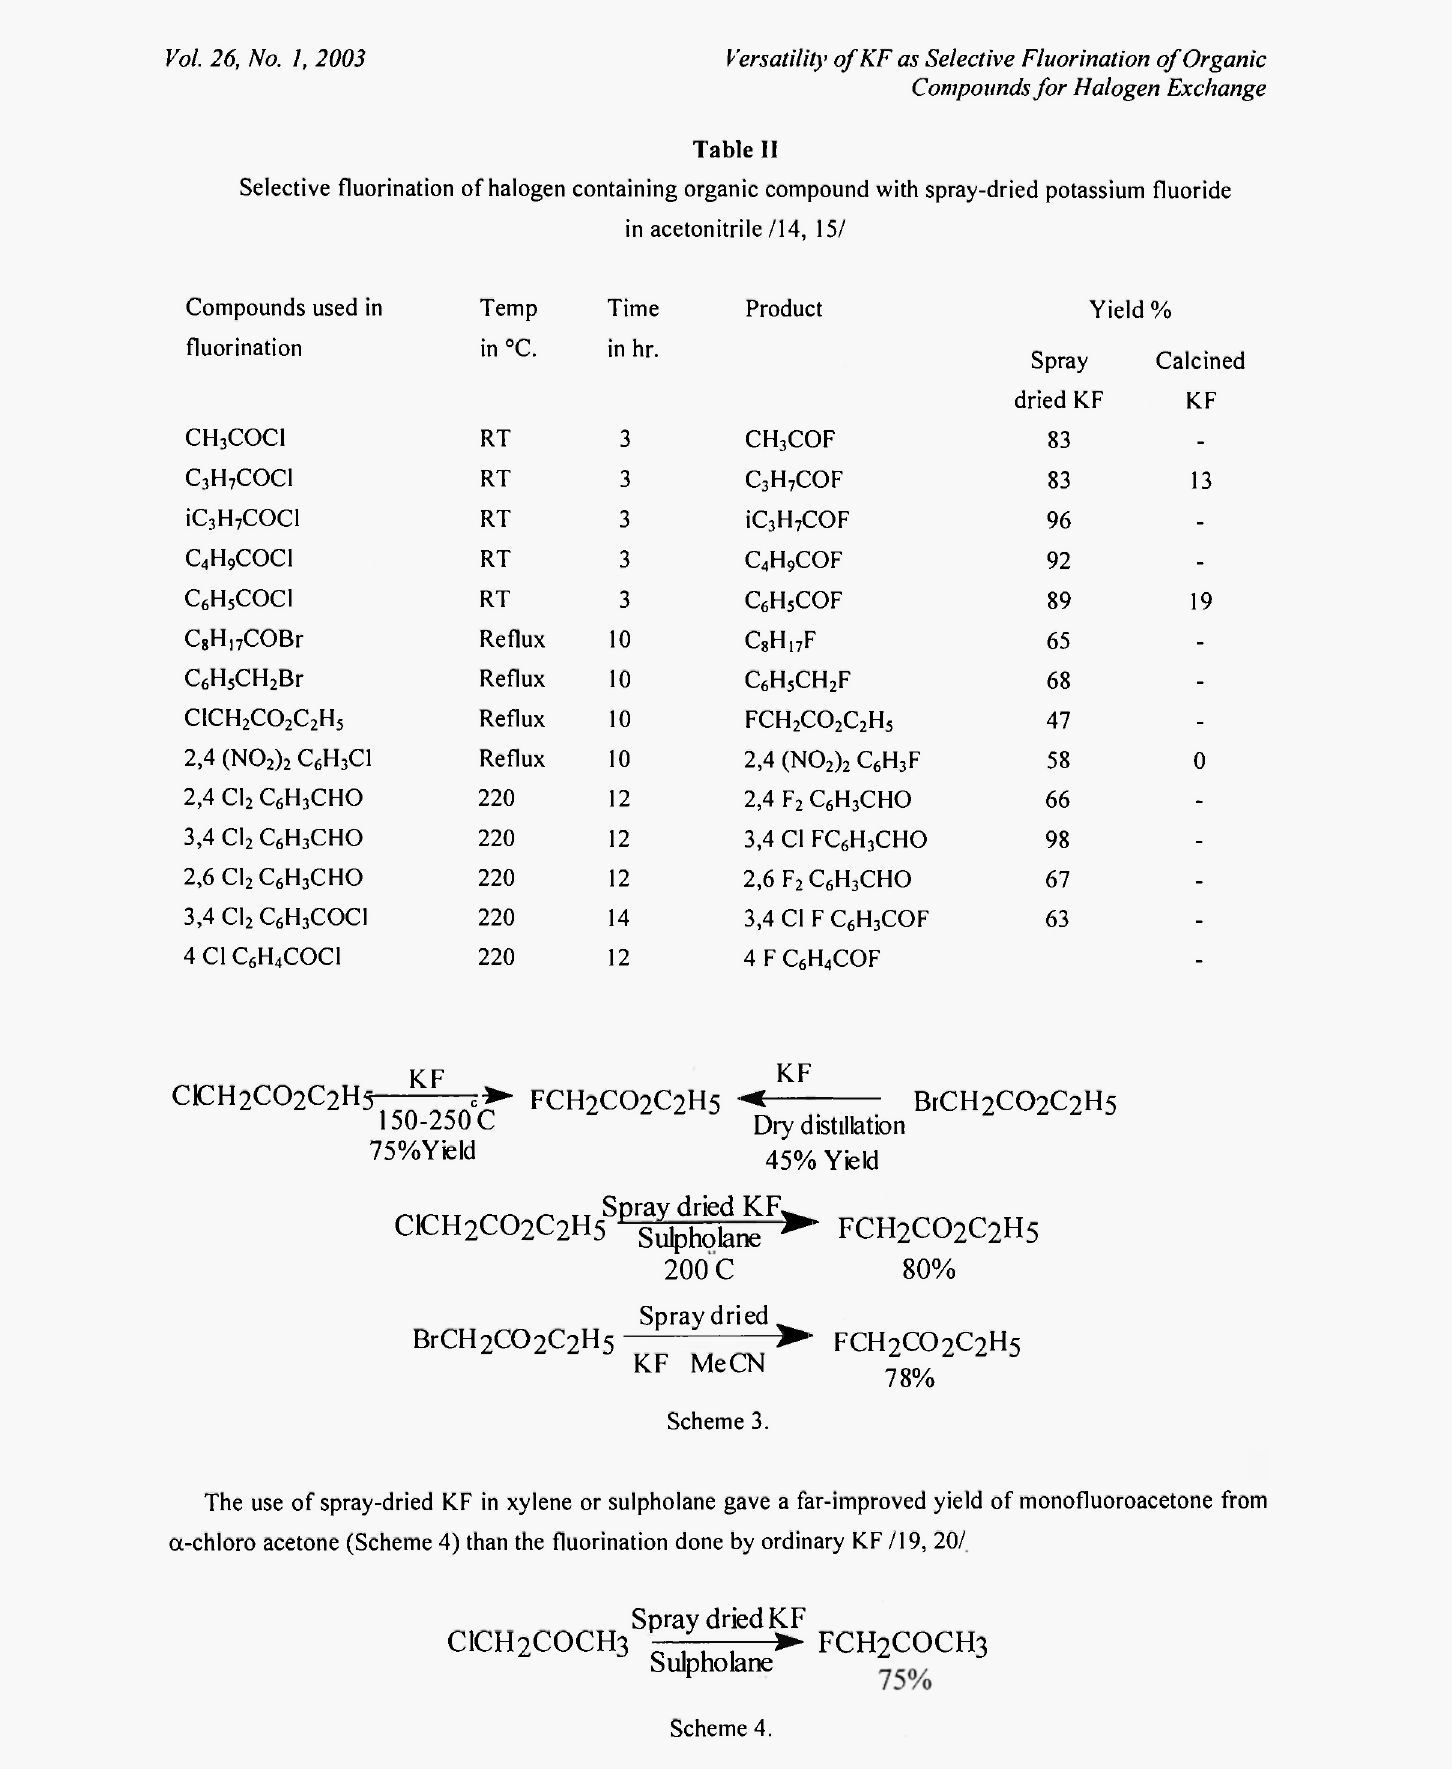
Selective fluorination of halogen containing organic compound with spray-dried potassium fluoride in acetonitrile /14, 15/